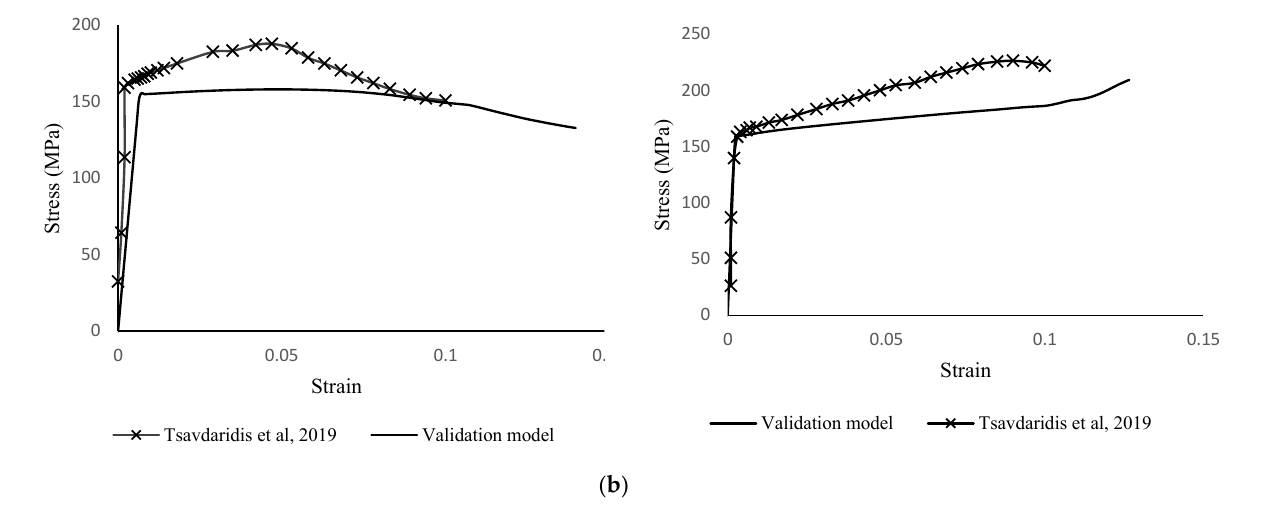
Figure 3. Validation analyses: ( a ) load–displacement curves—SV1 ( left ), load–displacement curves for various mesh sizes [1] ( right ). ( b ) Stress–strain curve—SV1 (up), stress–strain curve—SV2 (down).